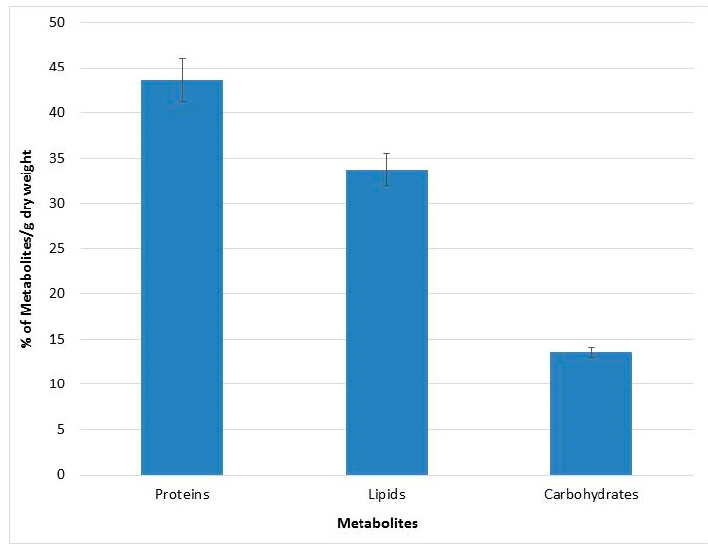
Figure 2. Metabolites characterization of Chlorella. sp . QUCCCM3.